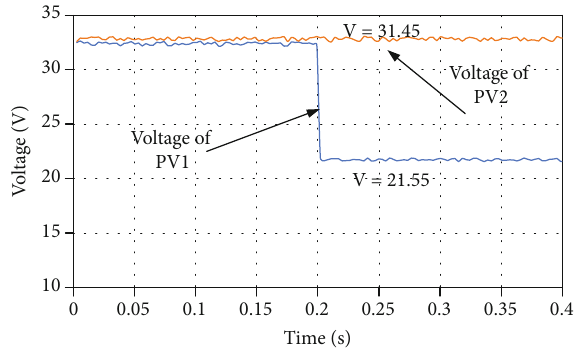
Figure 46: The output voltage of PV1, when the MOSFET of converter 1